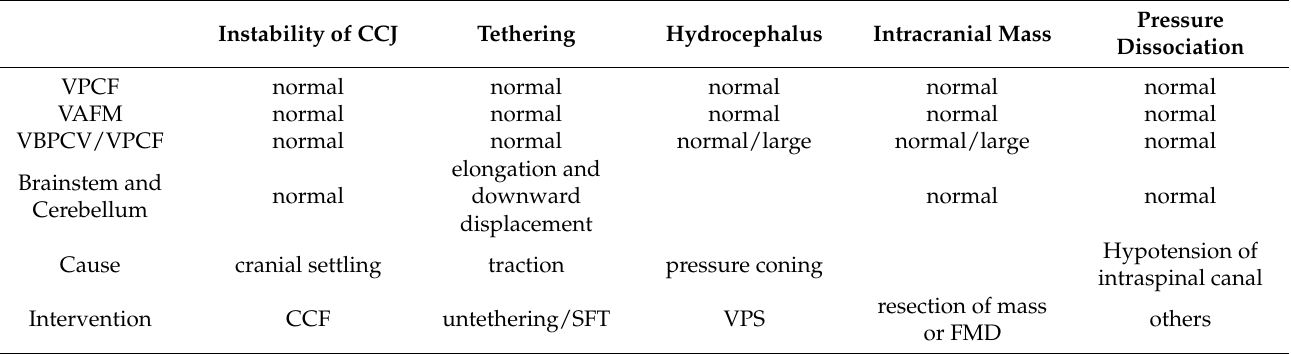
Table 2. Morphometric characterization and other mechanisms of hindbrain ptosis in CM-I type A, and the corresponding surgical intervention. Instability of CCJ Tethering Hydrocephalus Intracranial Mass